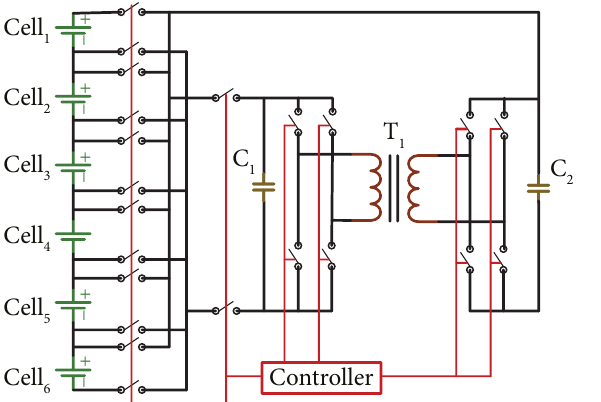
Figure 11: Dual active bridge converter-based